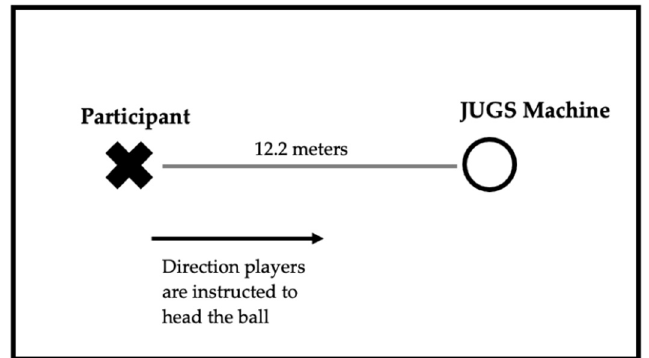
Figure 1. SWAY Balance stances from left to right: Feet together, tandem right, tandem left, single-leg right, and single-leg left.